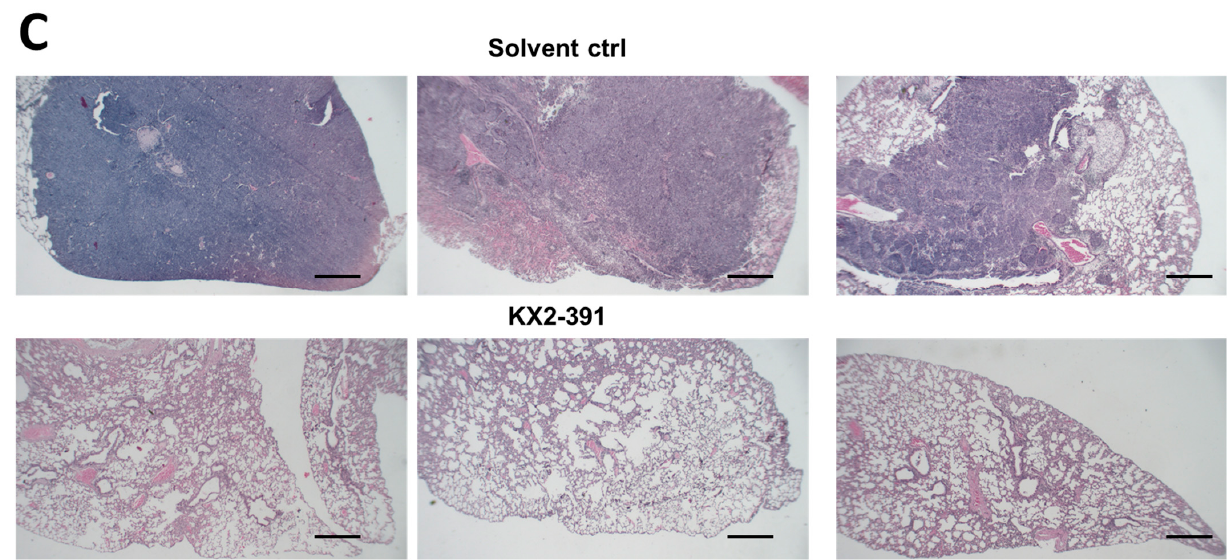
Figure 6. KX2-391 inhibits the lung metastasis of NPC cells. ( A ) The body weight of the mice in the treatment with KX2-391 was analyzed. ( B ) The in fi ltrated HONE1 cells in the lungs were re fl ected by the bioluminescence signals in the nude mice ( n = 8). The luminescence readings from all the mice were presented as a box plot, and each data point was shown. ( C ) Representative H&E staining of the mouse lungs (Scale bar, 2